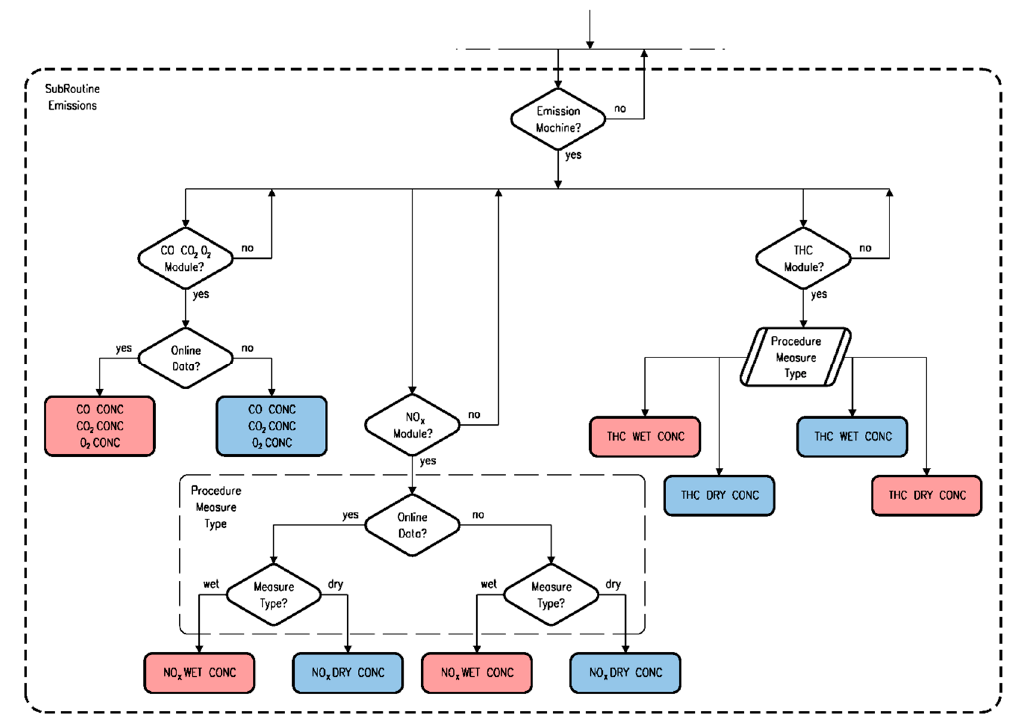
Figure 4. Emission SubRoutine.